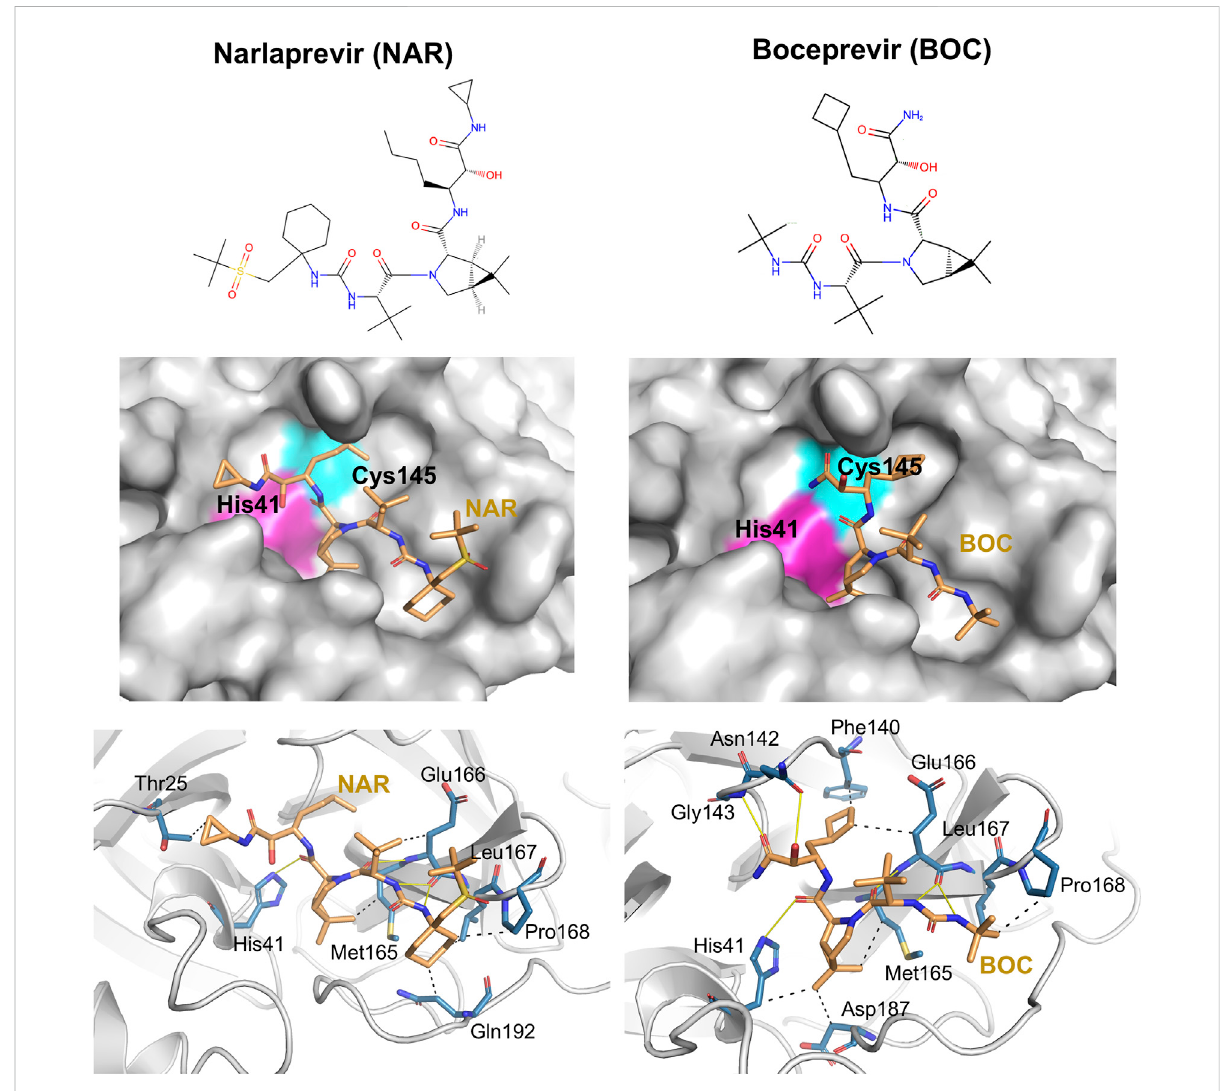
FIGURE 6 Docking ofHCVproteaseNS3/4Ainhibitordrugs to SARS-CoV2 3CL pro .Top panels -Molecular structures oftwoHCV protease inhibitor drugs. Middle panels — Lowest energy AutoDock pose of these HCV protease inhibitors (orange sticks) in the SARS CoV2 3CL pro active site, Bottom panels — Details of atomistic interactions in the lowest energy AutoDock poses of these HCV protease inhibitors. Hydrogen bonds and hydrophobic interactions between the drug and the enzyme are shown with yellow solid lines and black dashed lines, respectively. Sidechains of catalytic residues His41 and Cys145 are labeled, along with other protein residues that form key interactions with these